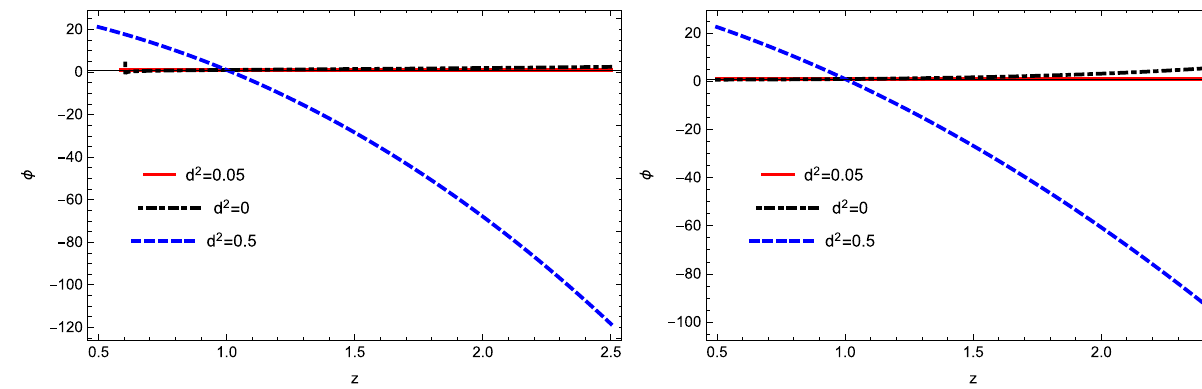
Fig. 25 Plot of φ verses z for u = 1 and u = 2 . 002 for K-essence scalar field model